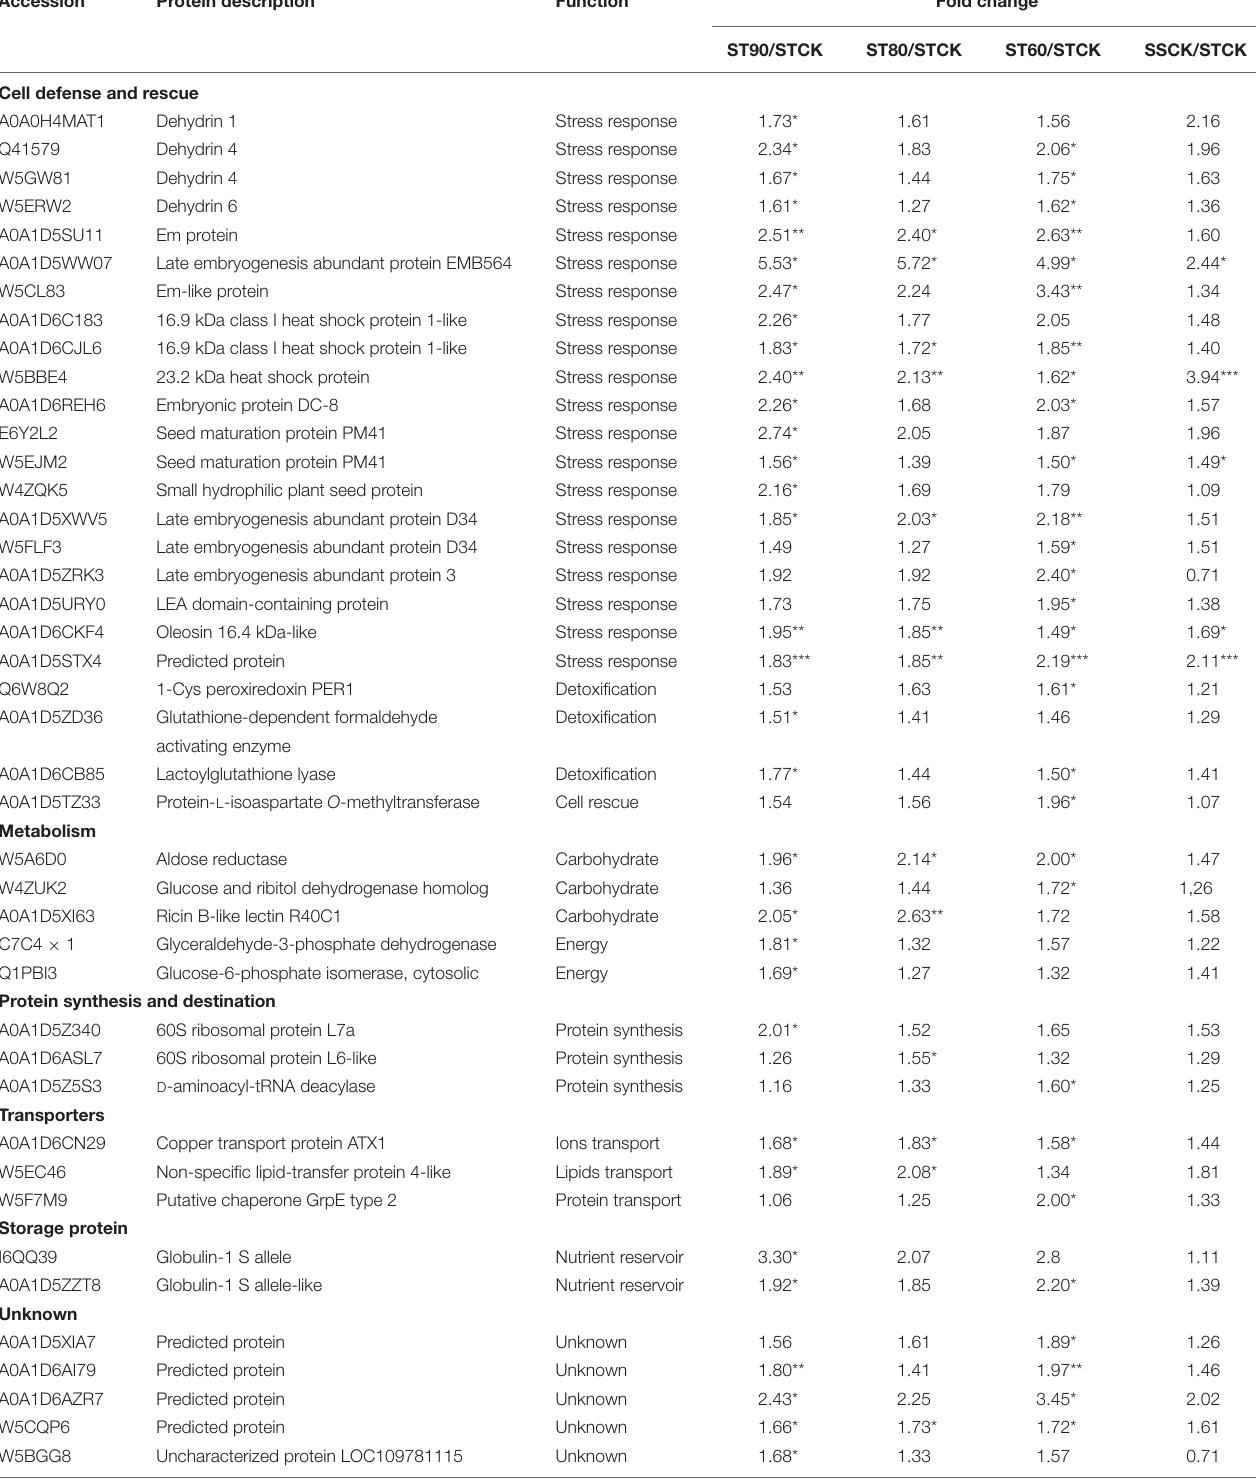
TABLE 1 | Differentially abundant proteins in embryos of ST seeds with significant trend in up-regulation during artificial aging at 40 ◦ C and 75% relative humidity. Accession Protein description